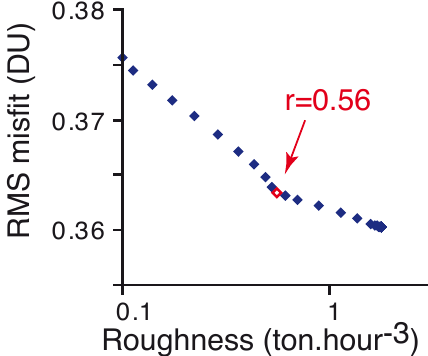
Figure 1. Normalised RMS misfit in Dobson units (DU) as a func- tion of solution roughness (th − 3 ), using the time series of IASI satellite observations from 10 April a.m. until 11 April p.m. 2011 in the inversion procedure. The optimal roughness is indicated in